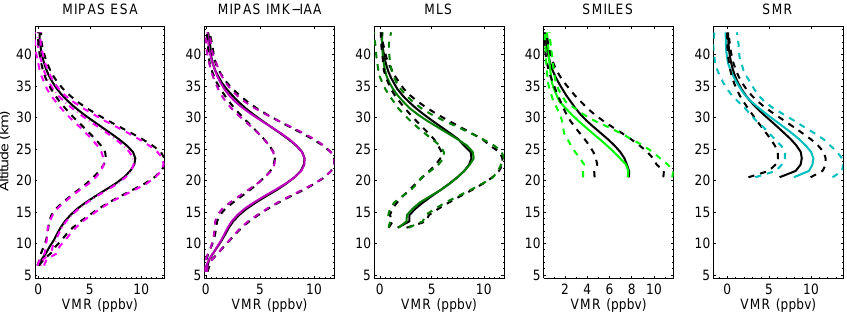
Figure 10. Mean HNO 3 profiles for coincident diurnally scaled ACE-FTS (black) and INST (coloured) measurements and corresponding measurement standard deviations (dashed lines). Coincidence criteria for all comparisons are within 6h and 100km.